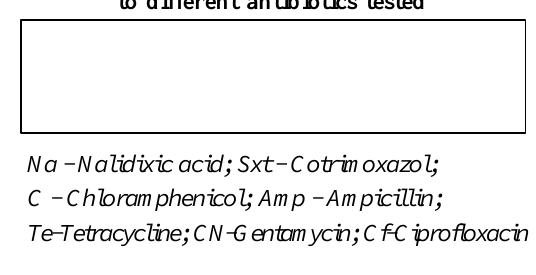
Table III : No of pathogens showing sensitivity to different